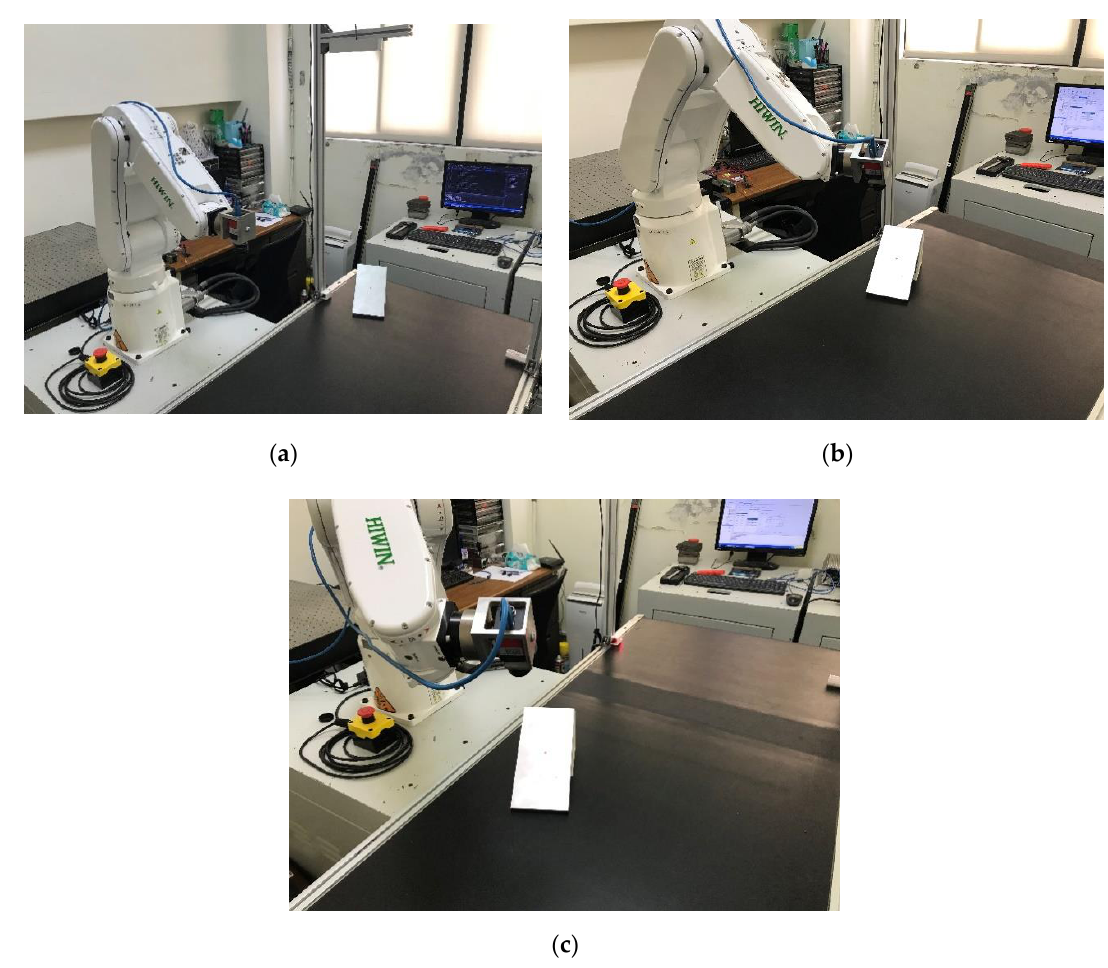
Figure 8. Demonstration of the experimental process: ( a ) An object was placed underneath the 3D scanner at a random position on the conveyer; ( b ) the industrial robot moved the camera to the desired position to face perpendicularly to the inspected surface on the object; ( c ) the camera moved with the movement of the object without stopping the conveyer.